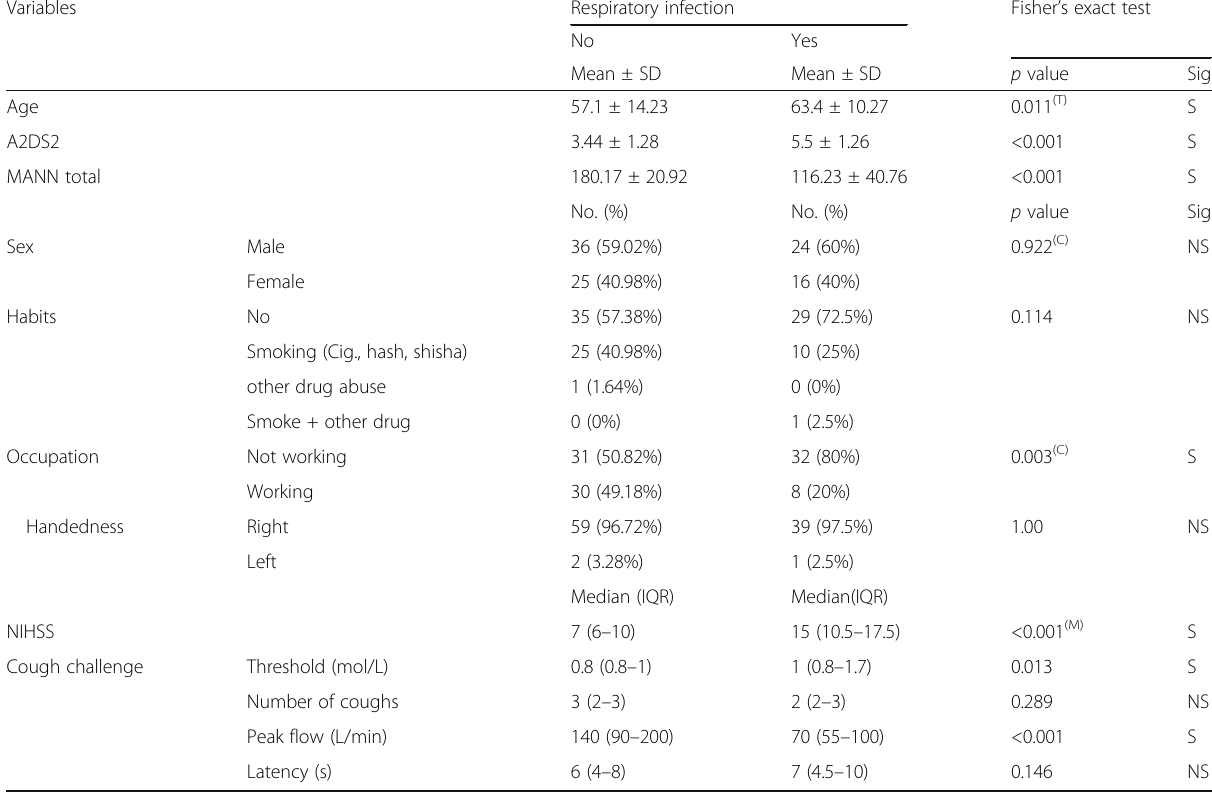
Table 3 Descriptive statistics and comparison according to the occurrence of respiratory infection Variables